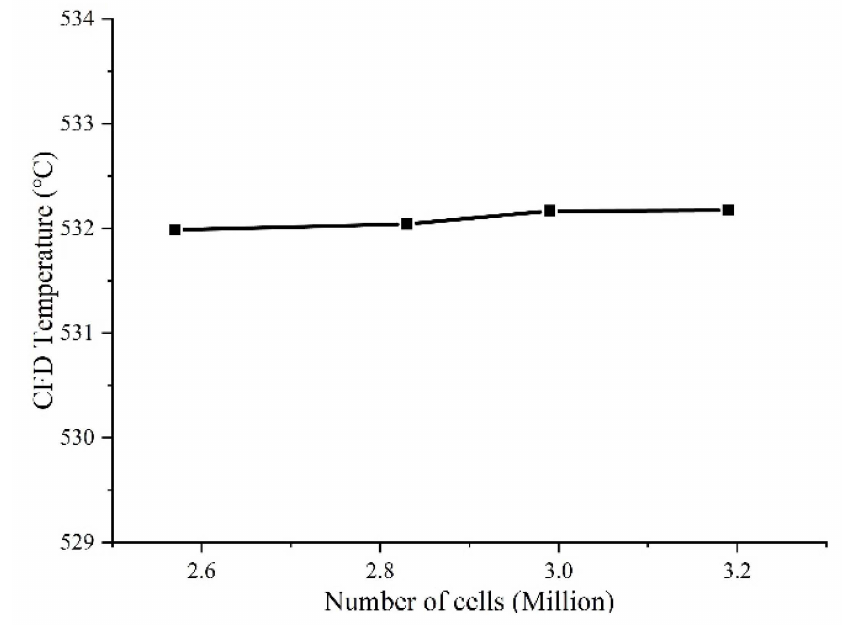
Figure 3. Mesh independence calculating